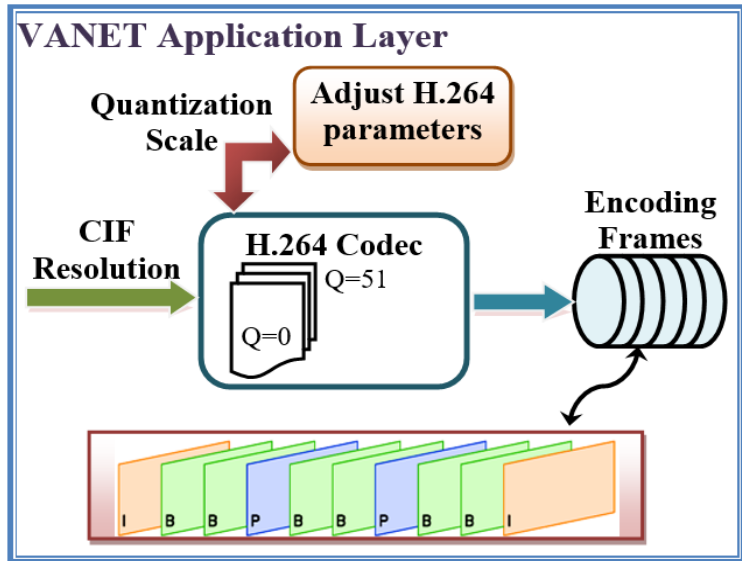
Figure 3. Block Diagram of Proposed Encoding Model.